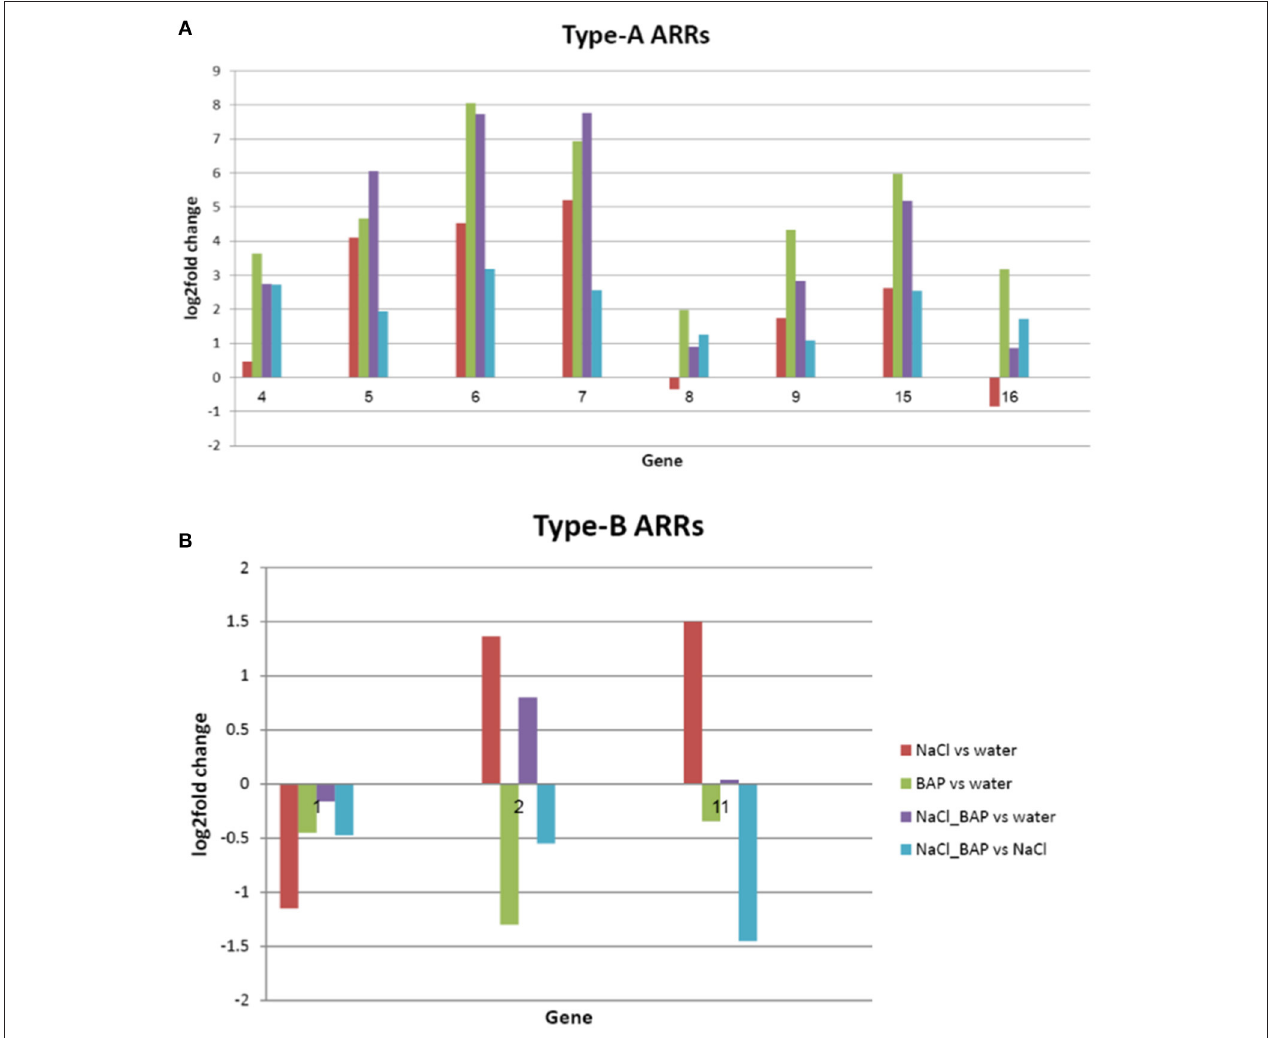
FIGURE 9 | Effect of CK on differential expression of (A) type-A and (B) type-B ARRs in plants under salinity stress (logarithmic scale). The bioinformatics enrichment analysis of our RNA sequencing data results, showed that 8 TCS genes (type A and type B response regulator proteins) had significantly different gene expression in salinity and salinity plus CK t ( P < 0.05). 4. ARR4 (AT1G10470); 5. ARR5 (AT3G48100); 6. ARR6 (AT5G62920); 7. ARR7 (AT1G19050); 8. ARR8 (AT2G41310); 9. ARR9 (AT3G57040); 15. ARR15 (AT1G74890);16. ARR16 (AT2G40670); 1. ARR1 (AT3G16857); 2. ARR2 (AT4G16110); and 11. ARR11